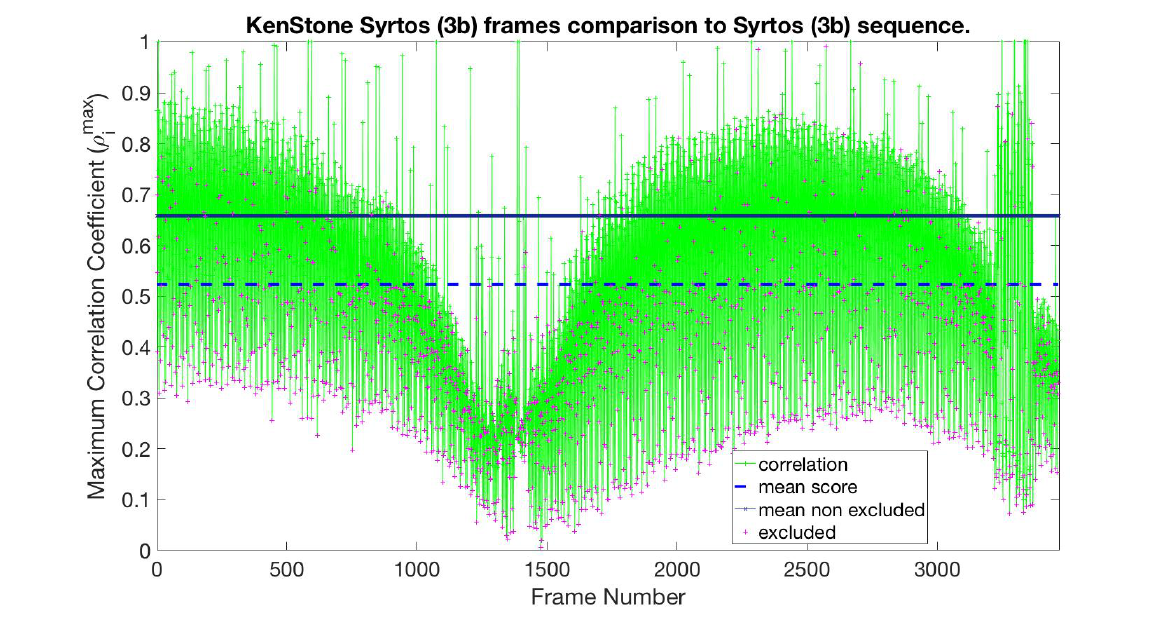
Figure 9. The maximum correlation scores ρ max sequence compared to the summarized one using Kennard